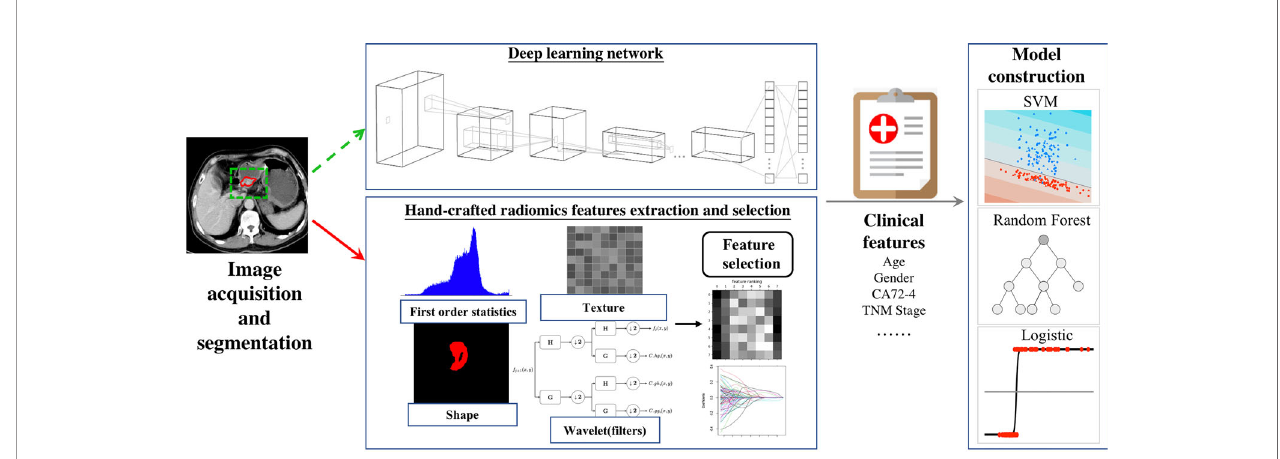
FIGURE 1 | The work fl ow of hand-crafted radiomics and deep learning methodological